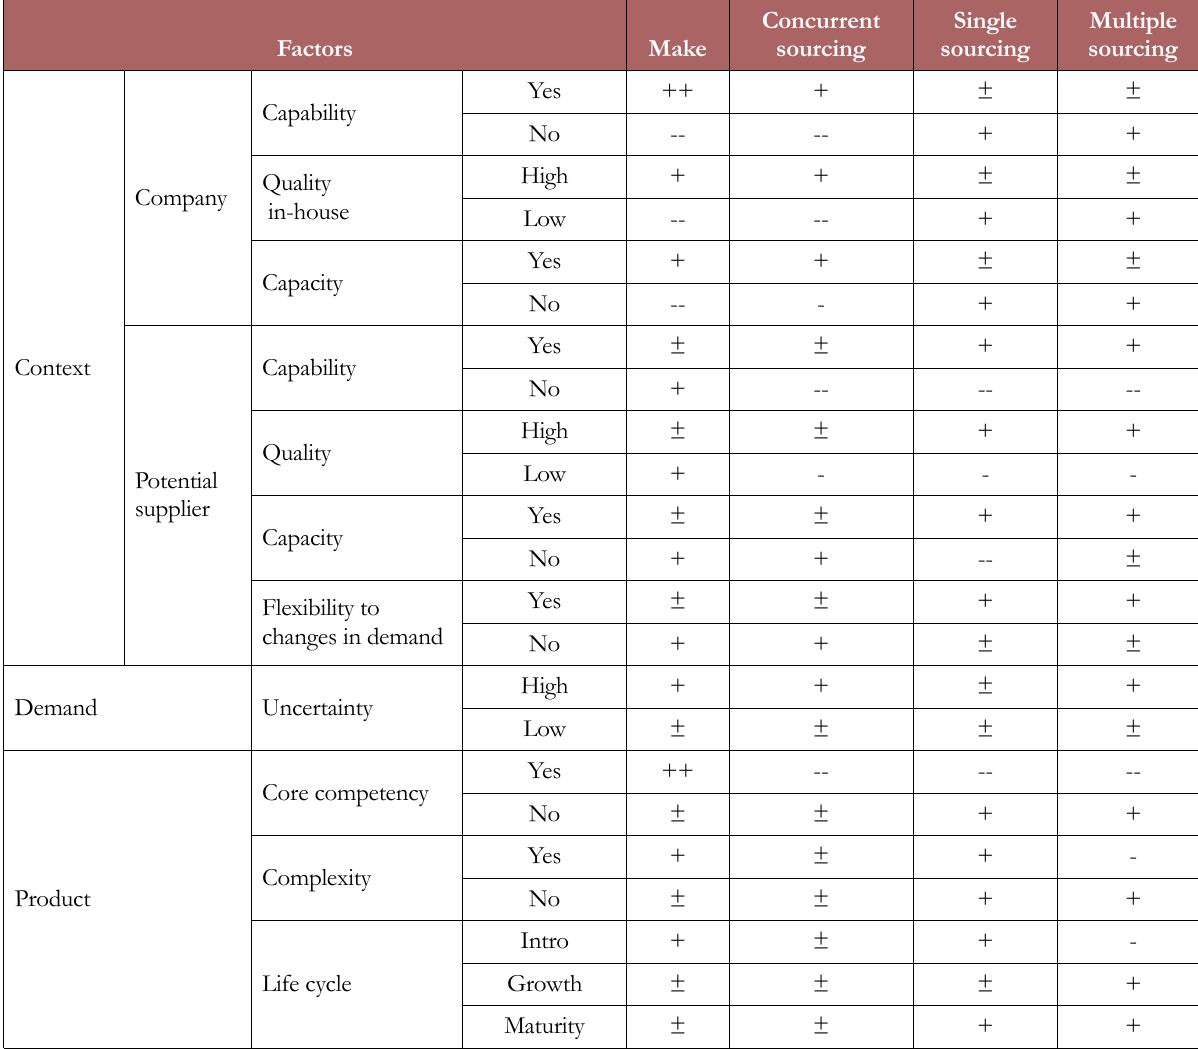
Table 3. Evaluation of the relevant factors to select the candidate sourcing